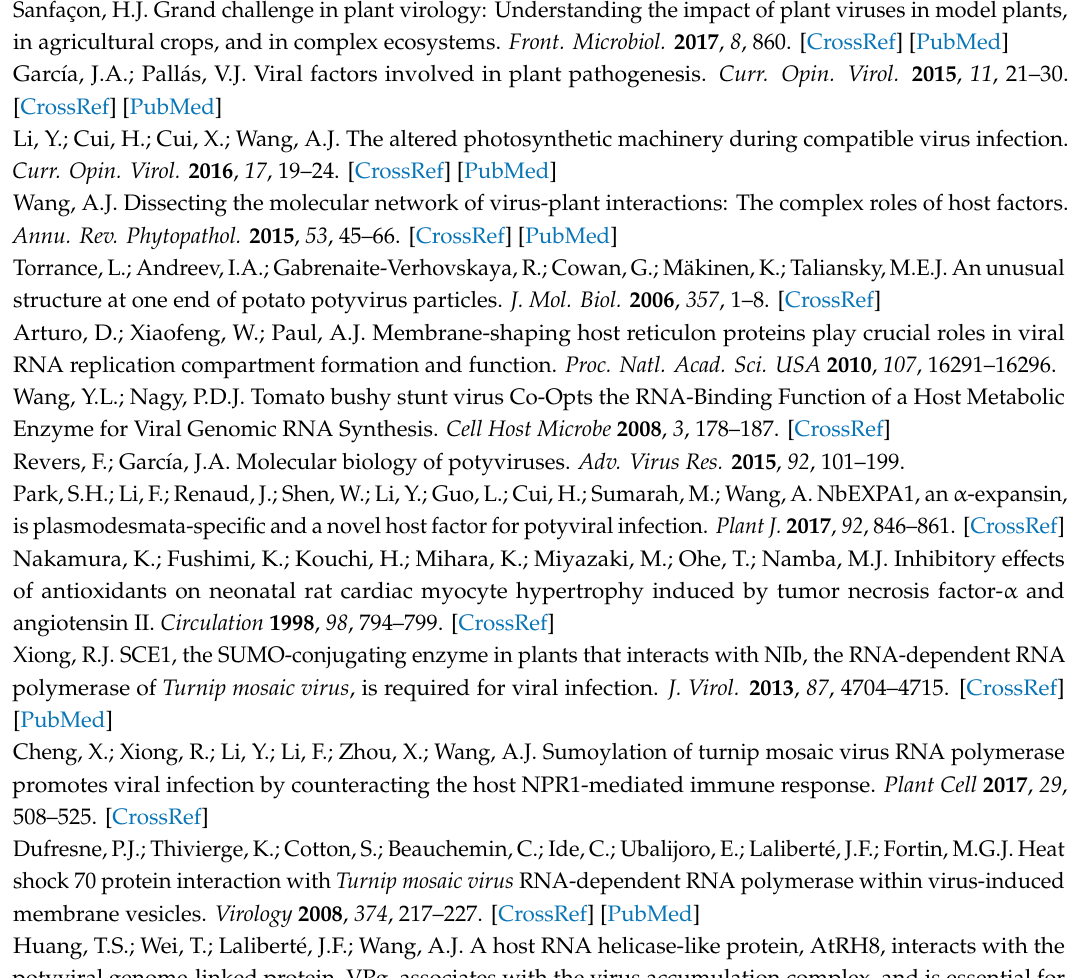
Figure S1. Sequence homology alignment between LIP homologous genes of six di ff erent species; Figure S2. Transcriptome analysis of WYMV-infected wheat. Healthy wheat was used as the negative control; Table S1. Information of proteins list obtained from Yeast two-hybrid assay; Table S2. The sequences of the primers used in these